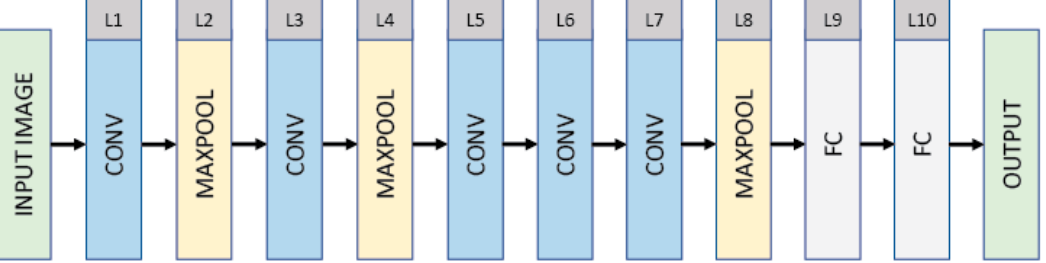
Figure 3. Architecture of convolutional neural network AlexNet consisting of 10 layers, excluding the input and output layers.